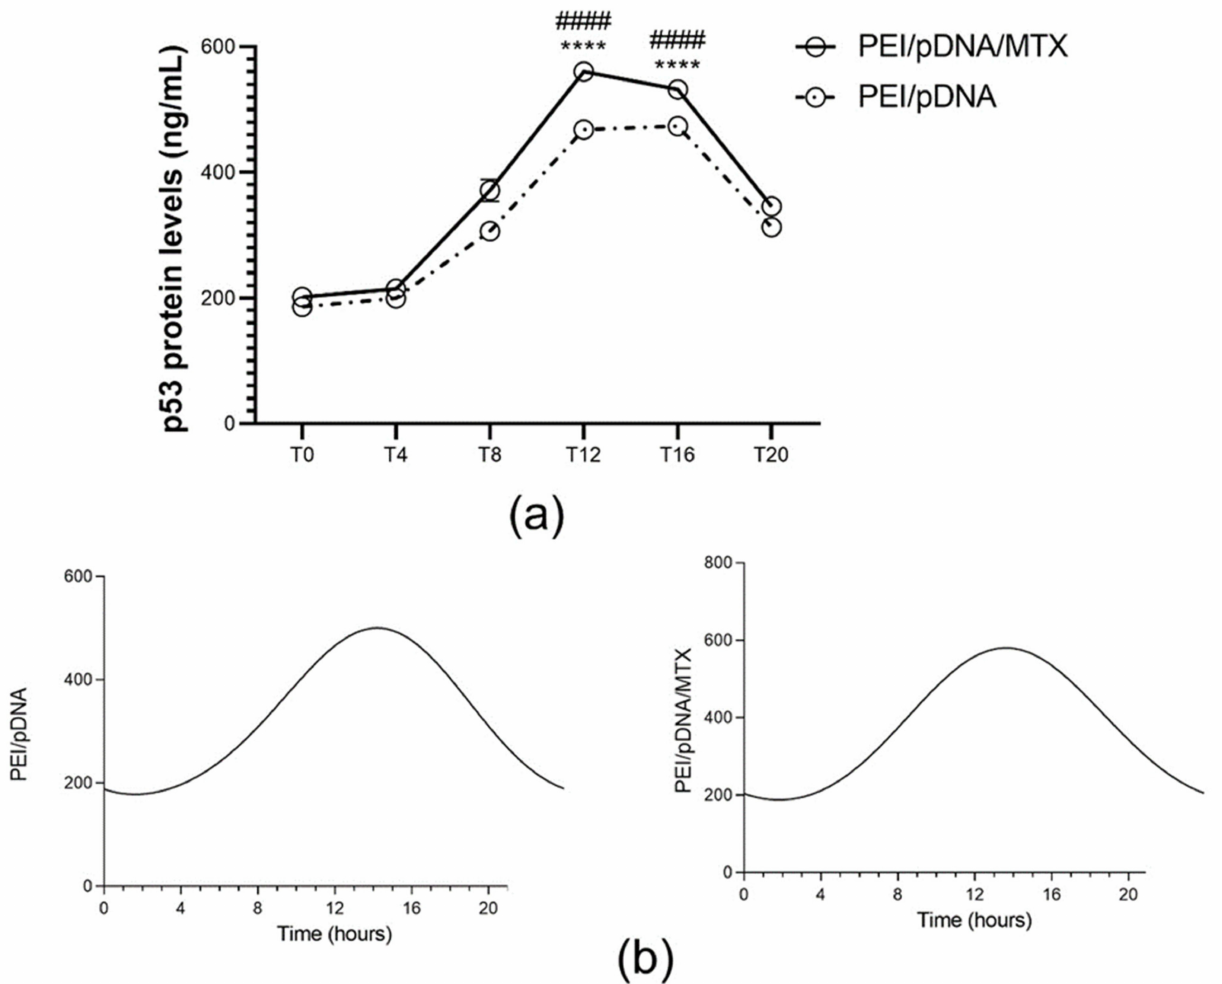
Figure 9. Quantification of p53 protein levels (ng/mL) for each time point. ( a ) p53 protein levels have been determined 48 h after transfection mediated by PEI/pDNA and PEI/pDNA/MTX nanoparticles by using the p53 pan ELISA kit. Each data point represents the mean ± SD (n = 3) and were analyzed by two-way ANOVA with the Bonferroni test. At time T12 and T16, substantial levels of protein were found in C33A cells, in comparison to other time points (**** p < 0.0001). Additionally, the difference between PEI/pDNA and PEI/pDNA/MTX is statistically significant for T12 and T16 (#### p < 0.0001). ( b ) Circadian oscillations are statistically significant as analyzed with CircWave ( p = 0 for both PEI/pDNA and